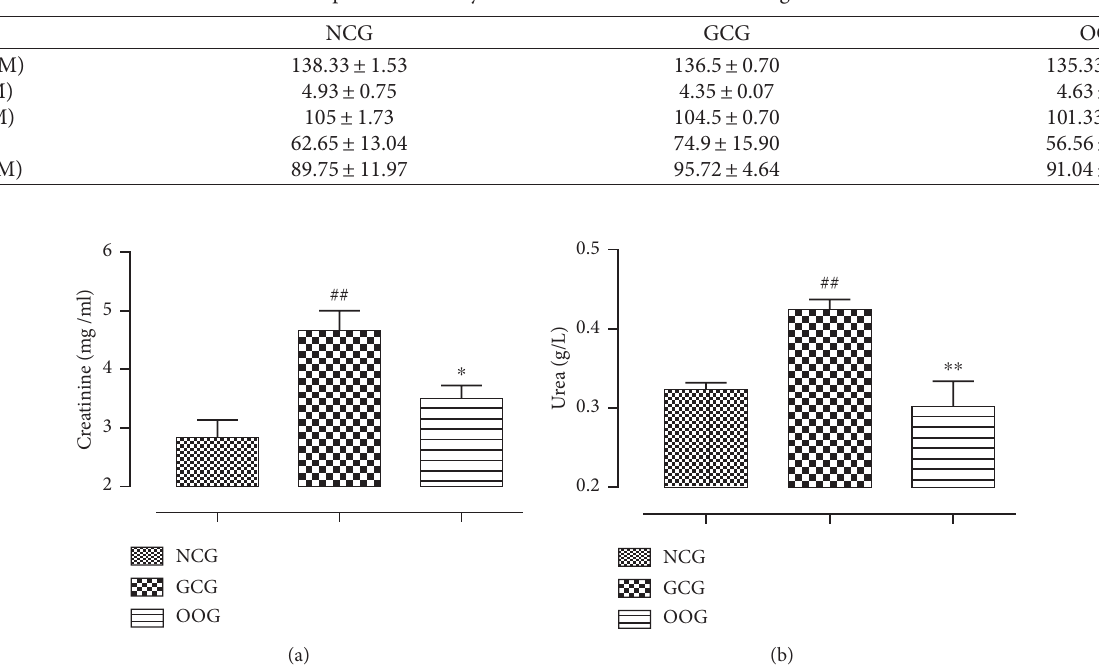
Figure 1: The amount of plasma creatinine (a) and urea (b) for all treated group animals. ## P < 0 . 01, compared to the NCG. ∗ P < 0 . 05 and ∗∗ p < 0 . 01, compared to the GCG.